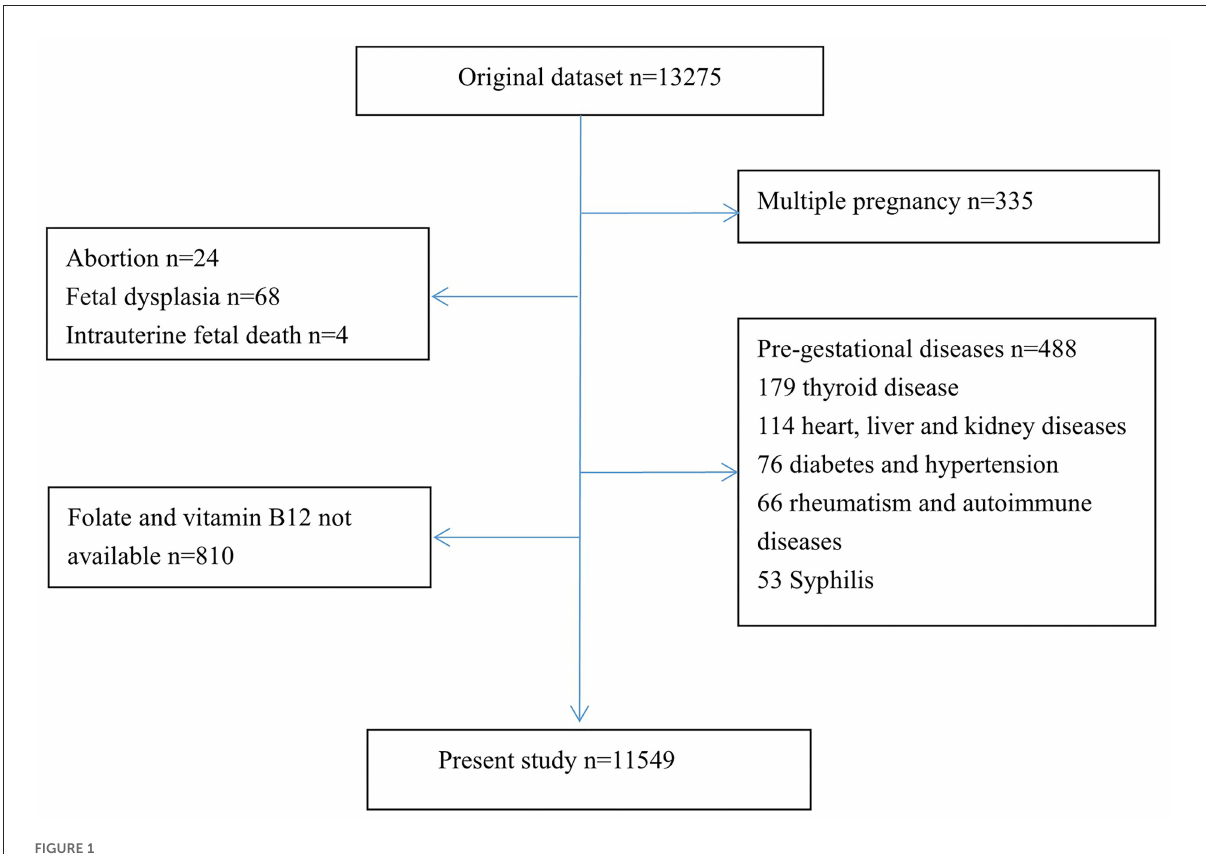
FIGURE1 Study flow